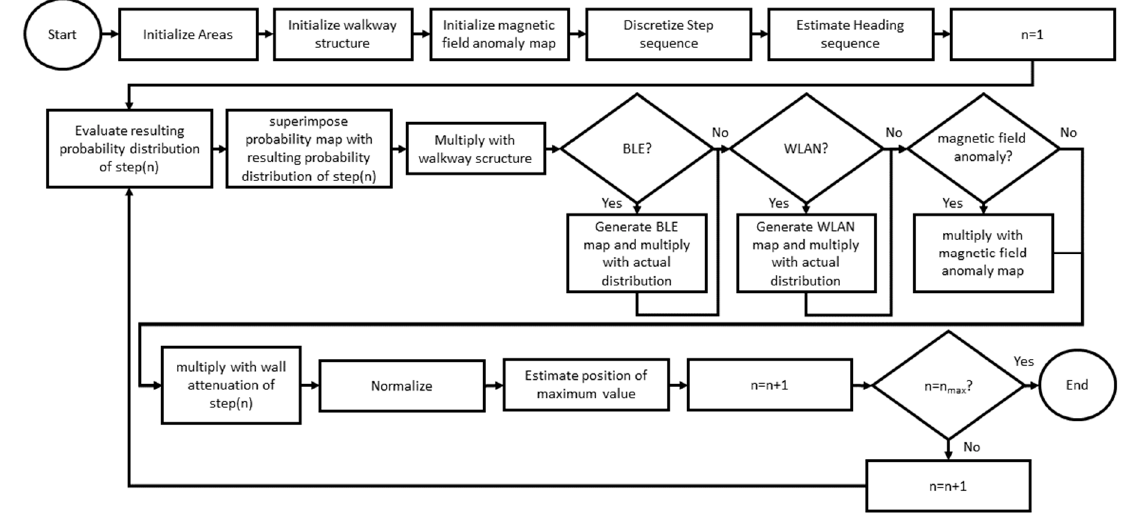
Figure 2. Workflow diagram for position estimation.